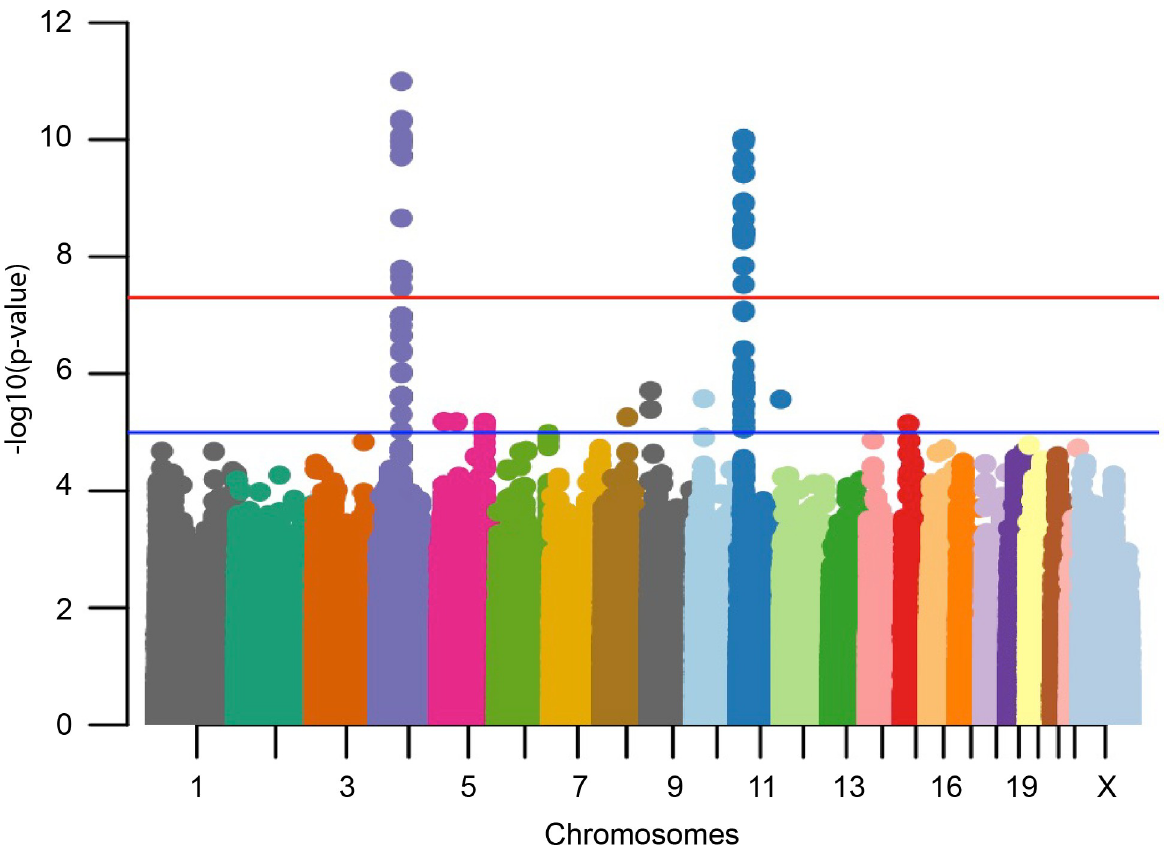
Fig 1. Association results for 25(OH)D concentration in 24-month old children. The results show two loci, one on chromosome 4 and one on chromosome 11, that are strongly associated to serum 25(OH)D concentration in 24-months old children. The genomic inflation factor ( λ ) for the association test is very close to 1 ( λ = 0.997), suggesting a solid dataset where the association statistics are not inflated due to population stratification or poor-quality